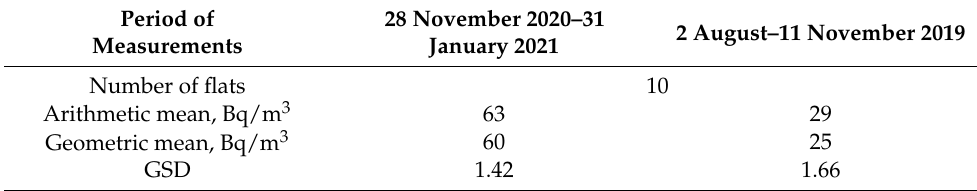
Table 2. Results of radon survey in